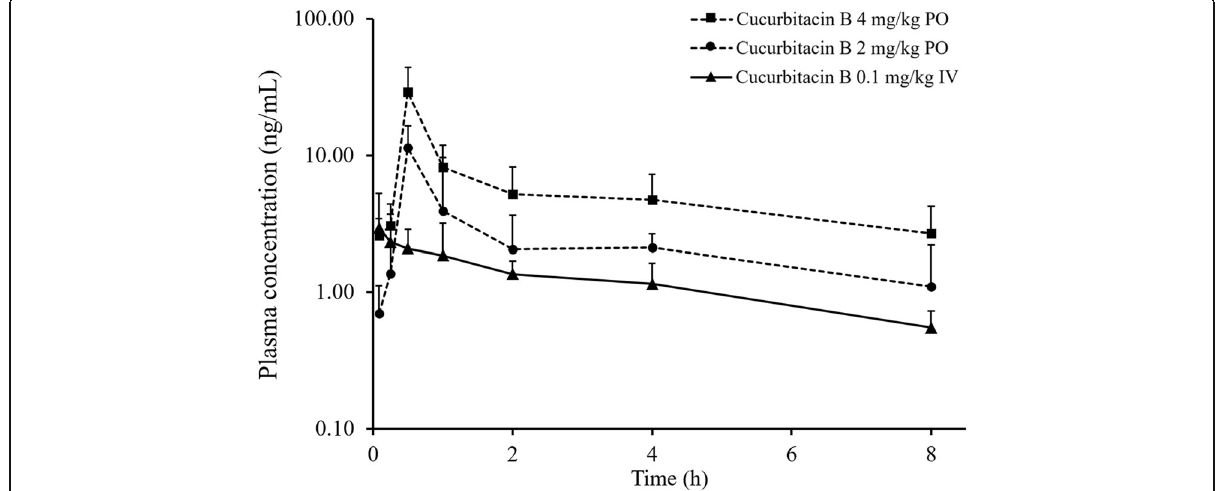
Fig. 3 Mean plasma concentration-time curves of cucurbitacin B after intravenous administration at 0.1 mg/kg ( − ▲ -) and oral administration at 2 mg/kg ( − ● -) and 4 mg/kg ( − ■ -). Each data point represents as mean ±